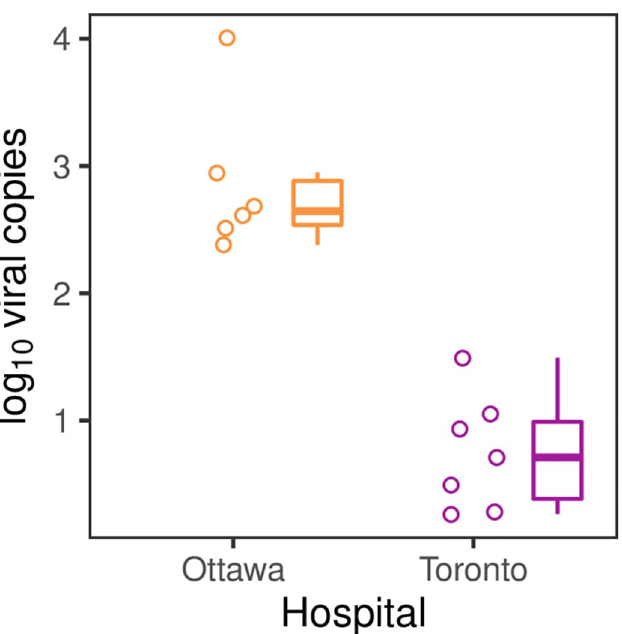
Fig 2. A comparison of detected SARS-CoV-2 quantities across COVID-19 patient rooms at two hospitals. Points show the patient room means of log 10 viral copies from all the positive swabs collected (negative results were excluded from the calculation of room-level means). Boxplots summarize these values for each hospital.